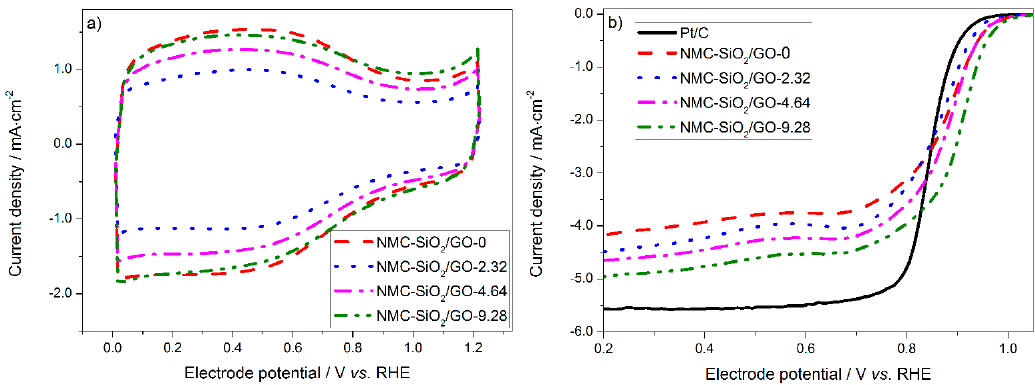
Figure 5. ( a ) Cyclic voltammograms in Ar-saturated 0.10 M KOH solution; ( b ) the corresponding oxygen reduction reaction (ORR) polarization curves in O 2 -saturated 0.10 M KOH solution. RHE: reversible hydrogen electrode.